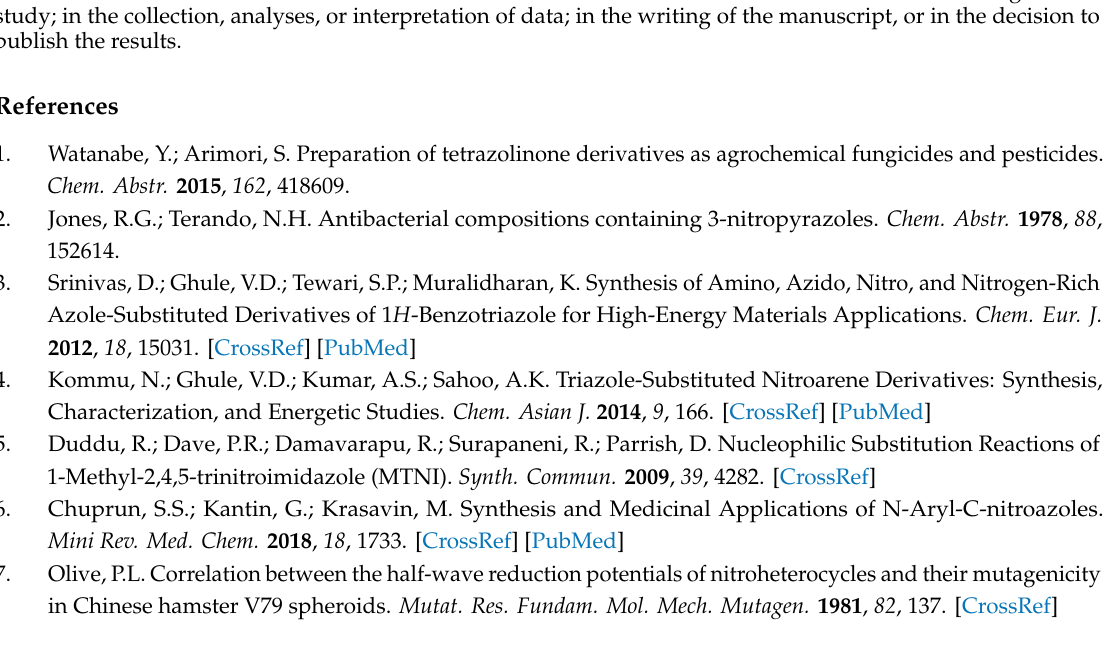
Table S1: Crystal data and structure refinement for 1e, 5; Table S2: Crystal data and structure refinement for 2o , 2k ; Table S3: Crystal data and structure refinement for 2n , 2h ; Copies of 1 H and 13 C NMR